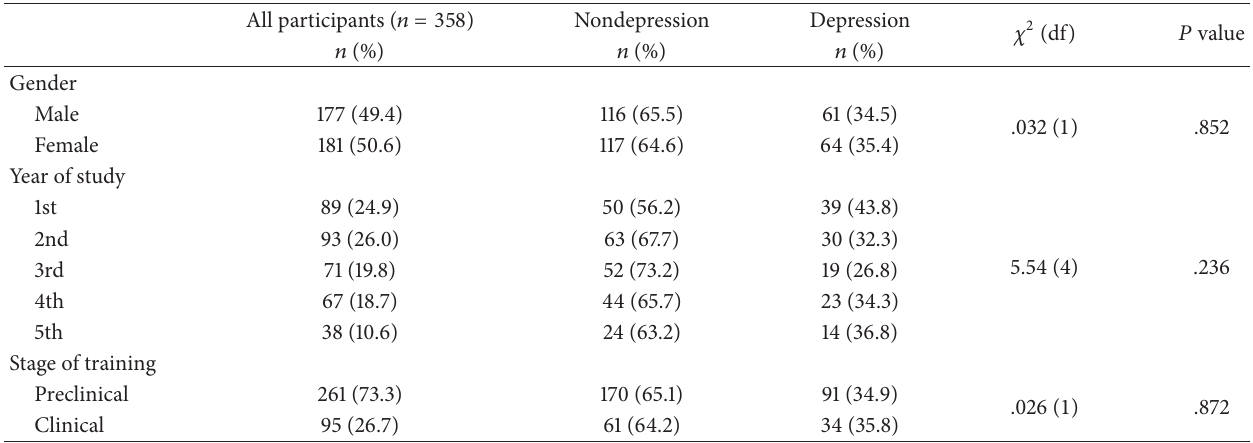
Table 2: Relationship between gender, year of study, and stage of training (clinical or nonclinical) with the existence or nonexistence of depression.